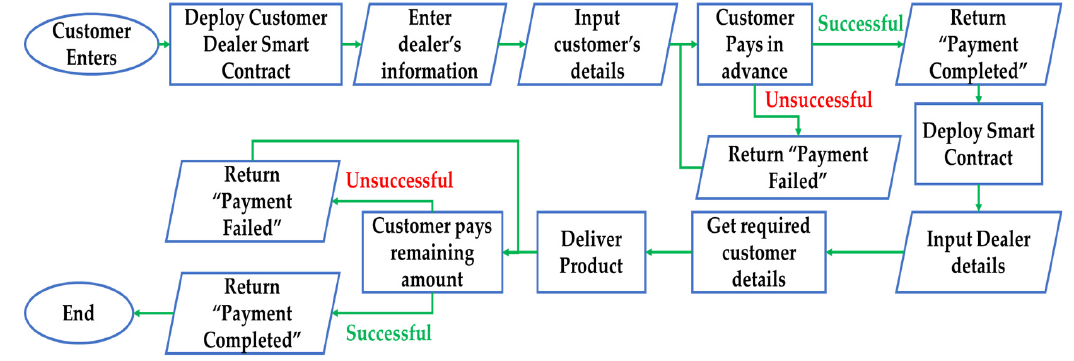
Figure 7. Smart contract execution between peers .